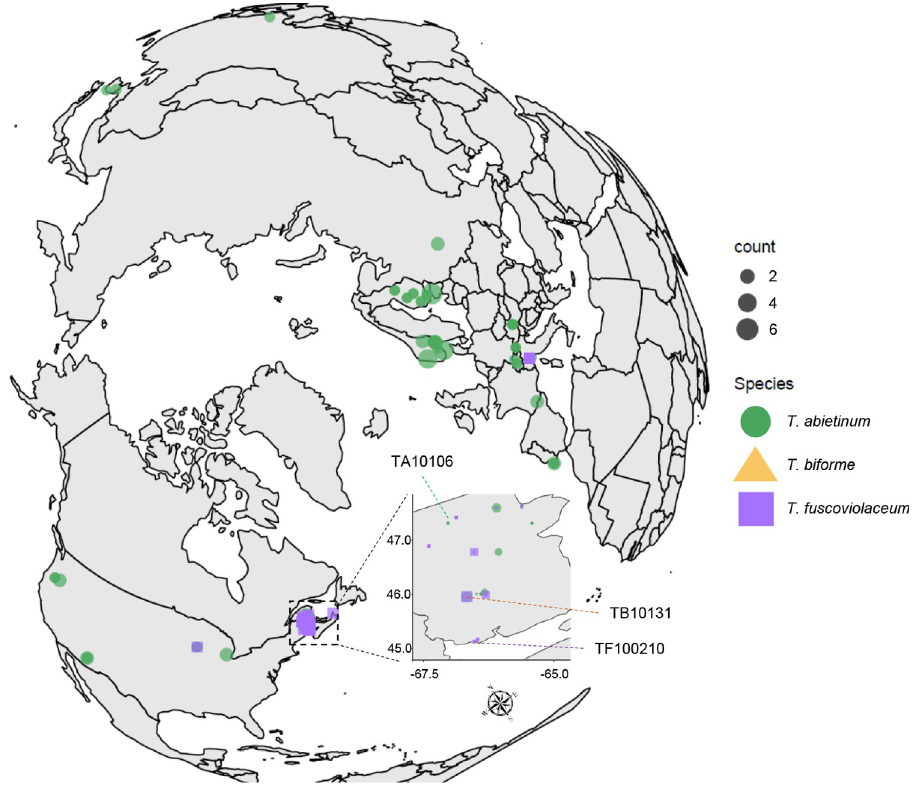
Fig 3. Circumboreal distribution of Trichaptum specimens. Geographic distribution of collected Trichaptum specimens. 77 European, 98 North American and 4 Asian Trichaptum specimens were collected in this study. Specimens were collected mainly from four plant hosts from the genus Abies , Larix , Picea and Pinus (Tables 2 and S1). Map was created using R and ggplot2